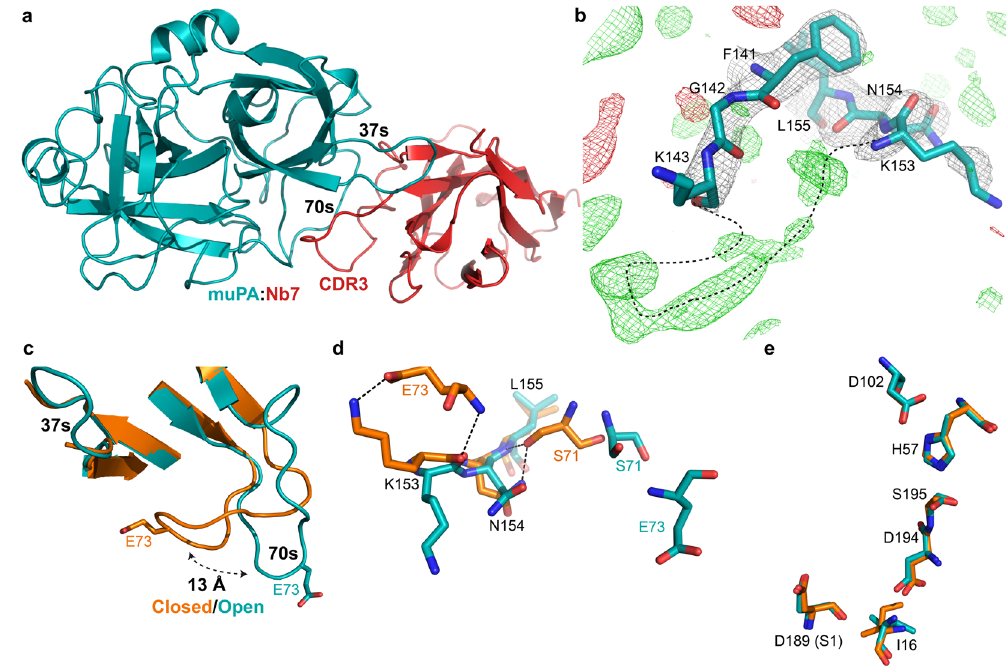
Figure 5. The muPA:Nb7 complex crystal structure. ( a ) Overall structure of the serine protease domain of muPA (teal) in complex with Nb7 (red). ( b ) Superposition of the structure around the 140s loop in muPA:Nb7 with the 2 F o – F c and F o – F c electron density maps at contour level σ = 1 (grey) and σ = ± 3 ( + green, − red) respectively. Black dashed line indicates a potential backbone trace of the 140s loop. ( c ) Structural comparison of the 37s and 70s loops in muPA between the muPA:Nb22 (orange) and muPA:Nb7 (teal) structures. ( d ) Superposition of the 70s/140s polar interaction network in muPA:Nb22 (orange) and muPA:Nb7 (teal) represented by sticks. ( e ) Structural comparison of the catalytic residues in muPA between the muPA:Nb22 structure (orange) and the muPA:Nb7 structure